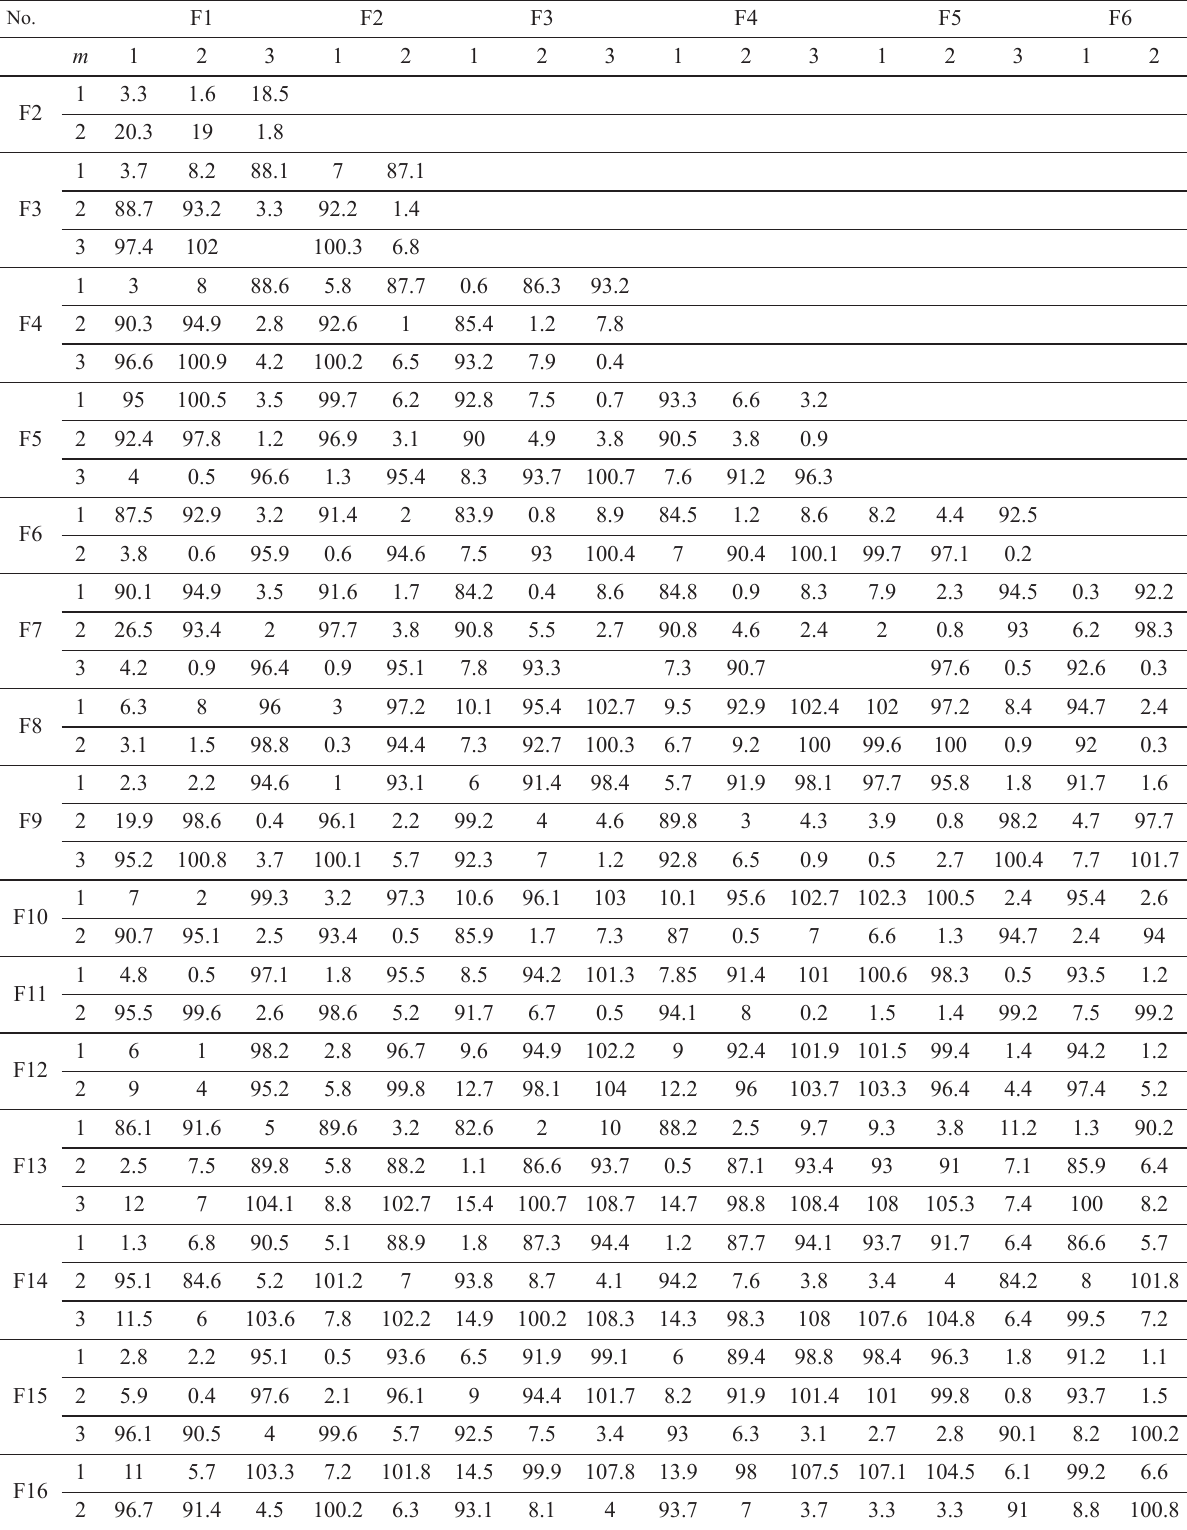
Table 4. The distance d ik , jl between different possible locations of the facilities (a)